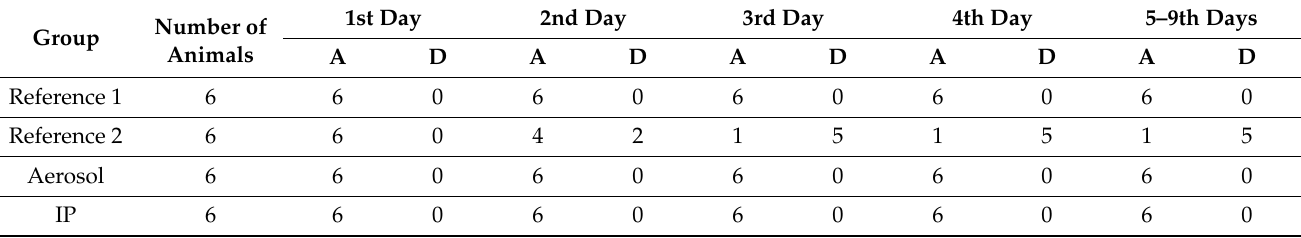
Table 10. Survival analysis of mice.